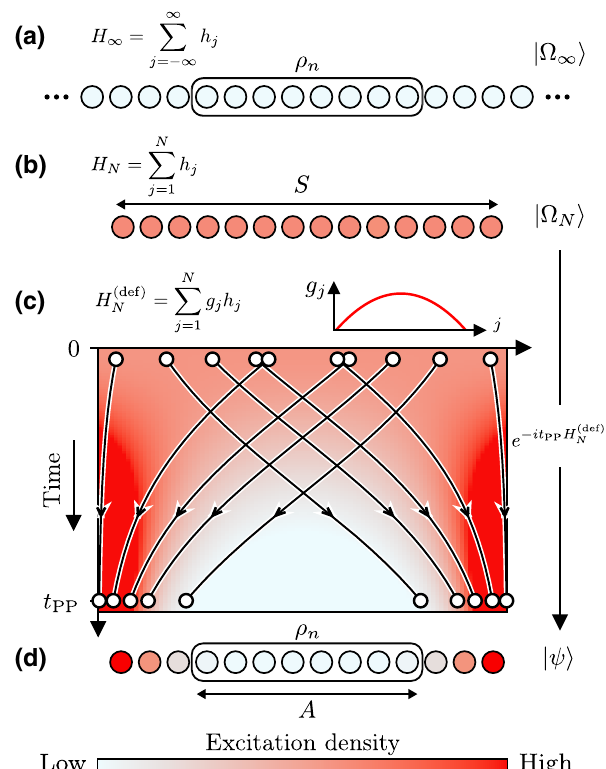
FIG. 1. Overview of purification preparation (PP), illustrated for a one-dimensional chain (see text). (a) Ground state | (cid:2) ∞ (cid:3) on an infinite-sized lattice with translation-invariant Hamilto- nian H ∞ composed of local operators h j . (b) The ground state (cid:3) for a finite-size system S can be interpreted as a part of | (cid:2) N (cid:3) , populated with low-energy excitations (quasiparticles). (c) | (cid:2) ∞ Density and trajectories of excitations, represented by circles, during coherent evolution with deformed Hamiltonian H ( def ) parametrized by g j , on the quantum simulator (obtained in the continuum limit of free-fermion system for evolution with a parabolically deformed Hamiltonian, see Appendix A). At time t PP the initial state | (cid:2) N (cid:3) is transformed into a purification | ψ (cid:3) . (d) The final state | ψ (cid:3) with subsystem A that corresponds to the part of | (cid:2) ∞ (cid:3) . White to red colors indicate the density of excitations (colorbar at the